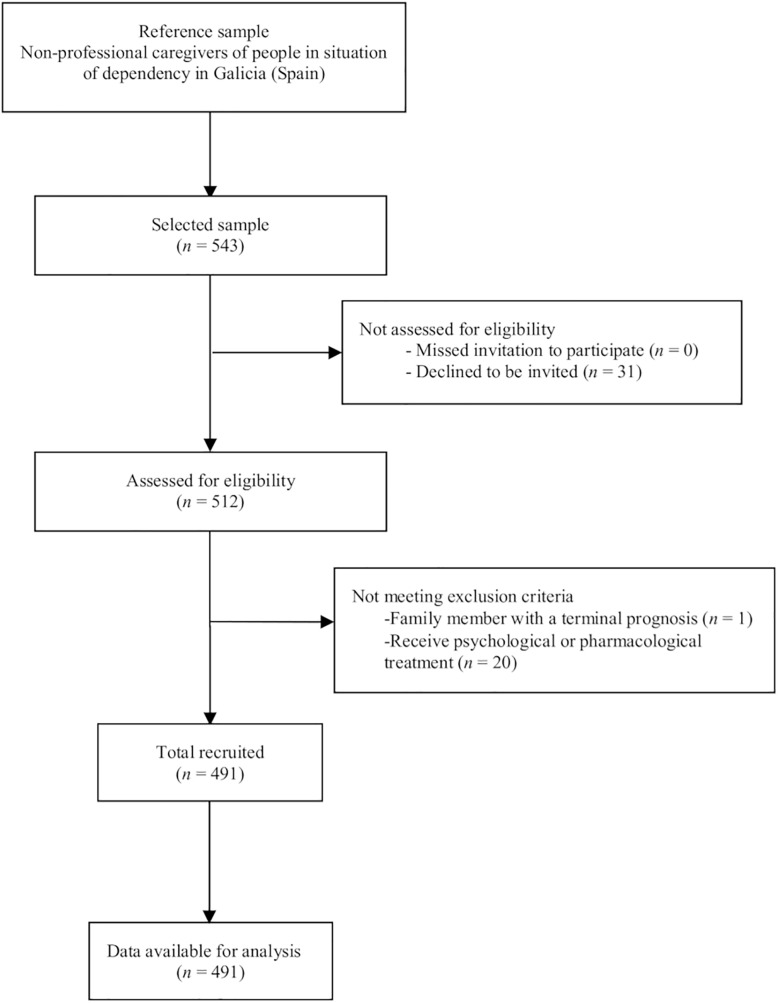
STROBE (Strengthening the Reporting of Observational Studies in Epidemiology) flow diagram.